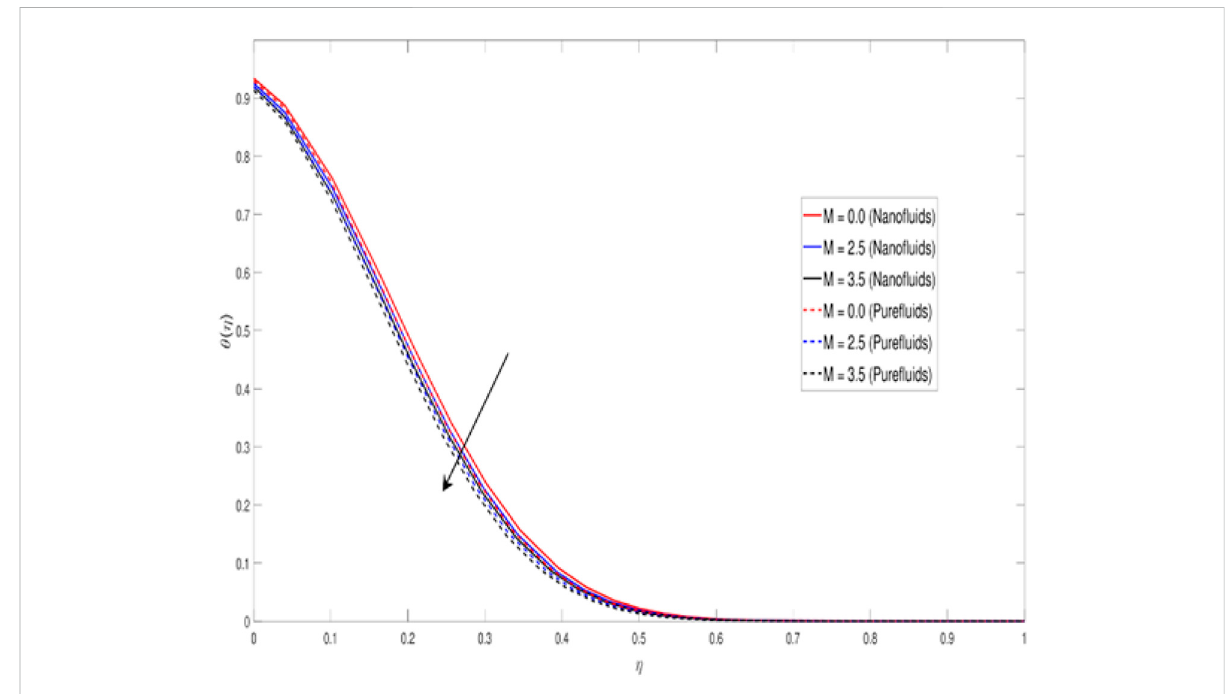
FIGURE 9 Temperature distribution vs. magnetic fi eld variation.